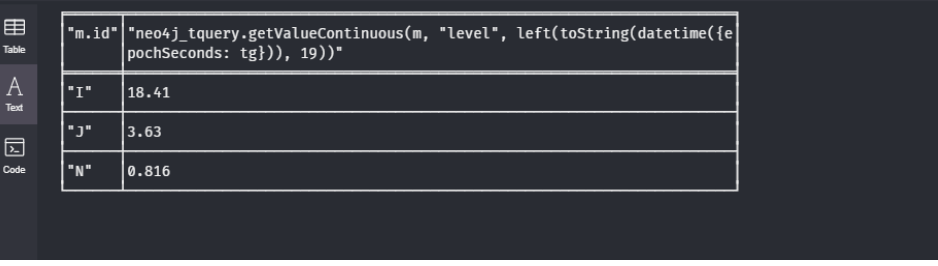
Figure 10. Visualization of the output of query Q 6 run on the sensor network of Figure 4. The result is taken from the web interface of